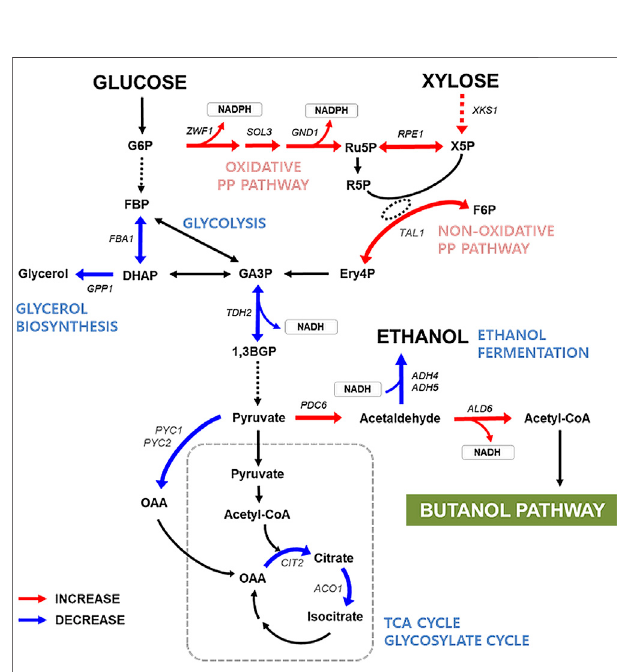
FIGURE 3 | Transcription levels of the genes involved in central carbon metabolism in the XUSEA-B strain during glucose or glucose/xylose co- fermentation.Red/bluearrowsindicatetheenzymaticstepswithmorethan2- fold increased/decreased transcription levels in XUSEA-B compared to those in WT-B strain. The cells were grown on glucose medium (20 g/L glucose) or a mixed-sugar medium (20 g/L glucose and 20 g/L xylose) under micro-aerobic conditions. Sampling was conducted during the exponential phase of cell growth. The gene symbols were referenced from the Saccharomyces Genome